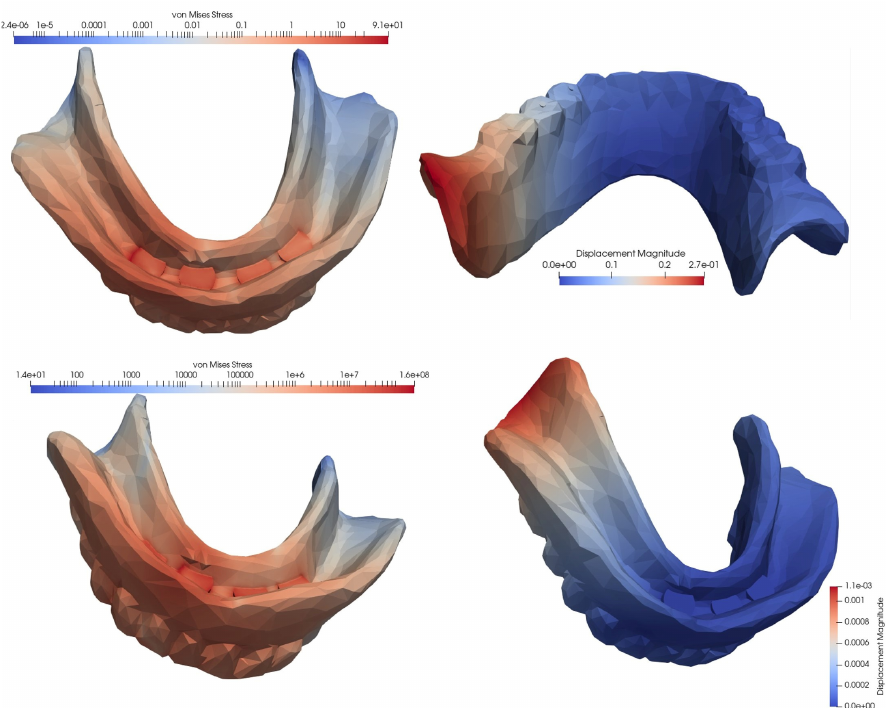
Figure 6. The von Mises stresses and displacements generated by the bilateral loading of an over- denture on four interforaminally inserted MDIs ( top ), compared to the loss of a distal implant ( bot- tom ).